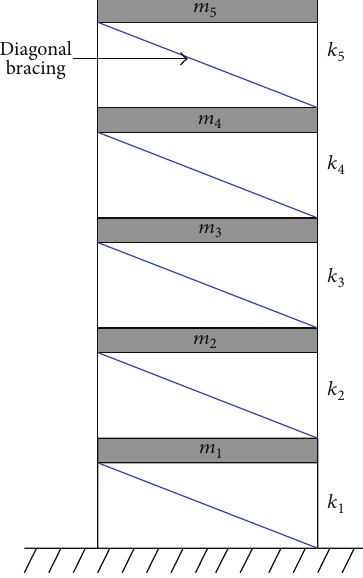
Figure 1: Illustrative diagram of a five-storey shear frame.